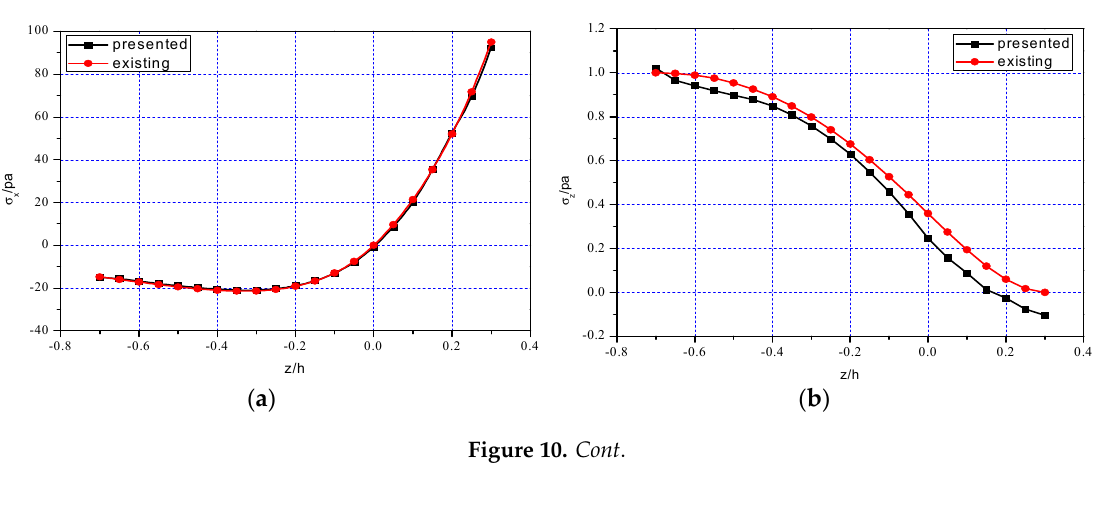
Figure 9. Comparisons of two-dimensional simulation presented in this study and existing solution from He et al. [27] at x = 0.5 l : ( a ) Stress σ x ; ( b ) Stress σ z ; ( c ) Stress τ xz ; ( d ) Electrical displacement D x ; ( e ) Electric displacement D z ; ( f ) Mechanical displacement u